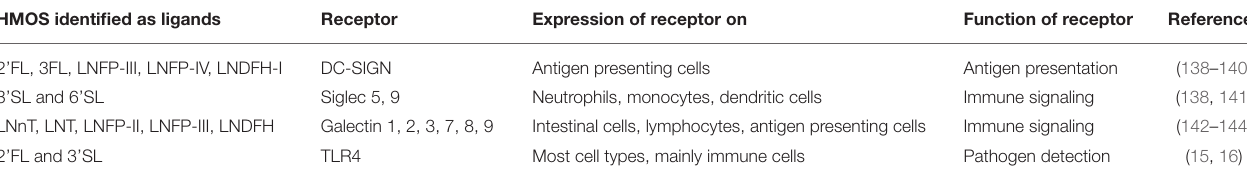
TABLE 1 | Overview of HMOS binding receptors, potentially involved in immunomodulation. HMOS identified as